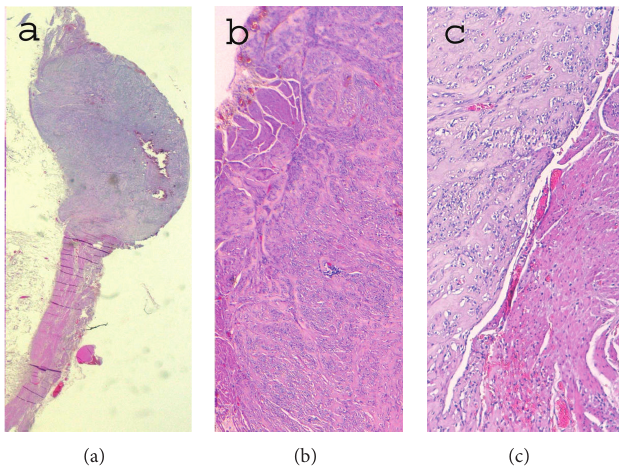
Figure 3: coexistent GIST EE: (a) GIST of the muscle wall of the gastric corpus—2x, (b) fusiform low grade GIST cells composed of spindle cells with ovoid nuclei arranged in short fascicles (nuclear palisading) —4x and (c) interface between GIST and gastric muscle wall—10x.